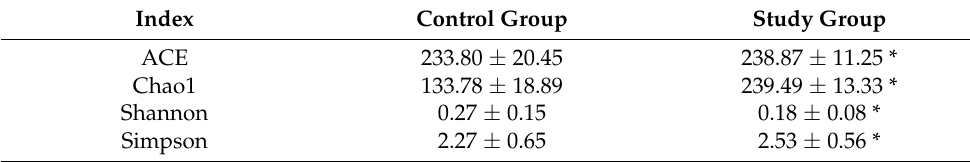
Table 7. Alpha diversity index